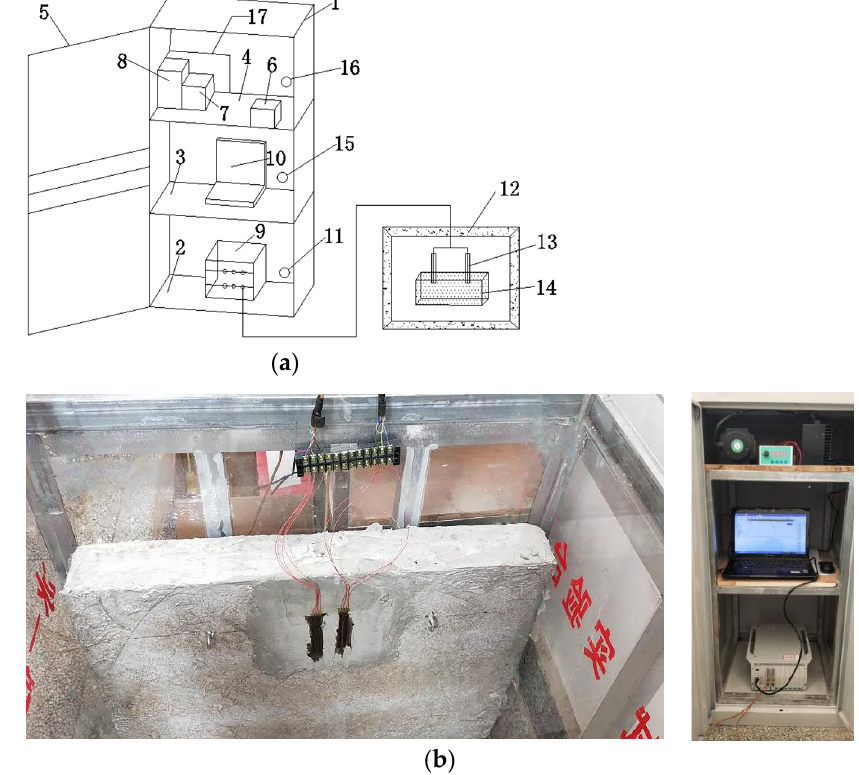
Figure 3. ( a ) Test setup diagram. 1. Instrument mounting cabinet. 2. Dynamic strain tester mounting table. 3. Computer mounting table. 4. Power system mounting table. 5. Cabinet doors. 6. Pulse trans-